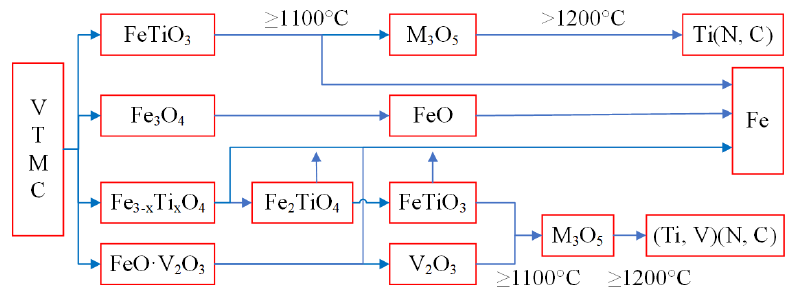
Figure 10. Path of carbothermic reduction and nitridation of